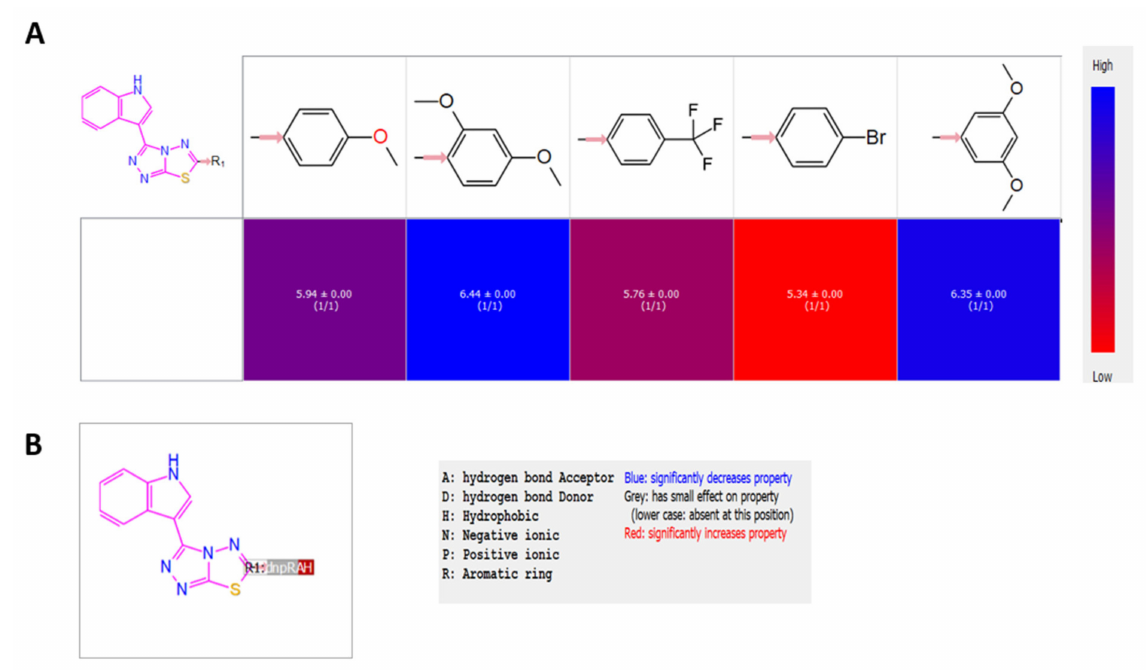
Figure 5. R-group analysis. ( A ) SAR analysis heat map. PIC 50 values were displayed as colours ranging from red to blue as shown in the key. ( B ) QSAR analysis. Pharmacophoric features were displayed as colours between red, grey and blue, as shown in the